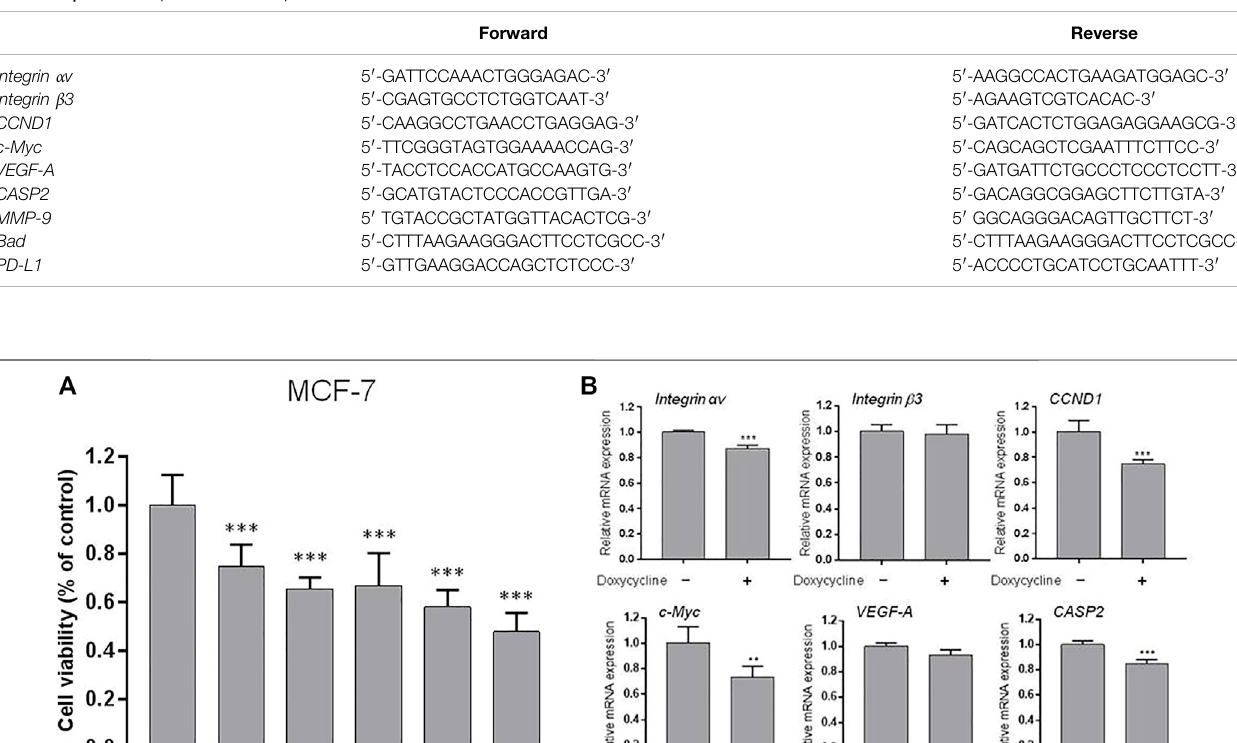
Frontiers in Cell and Developmental Biology |